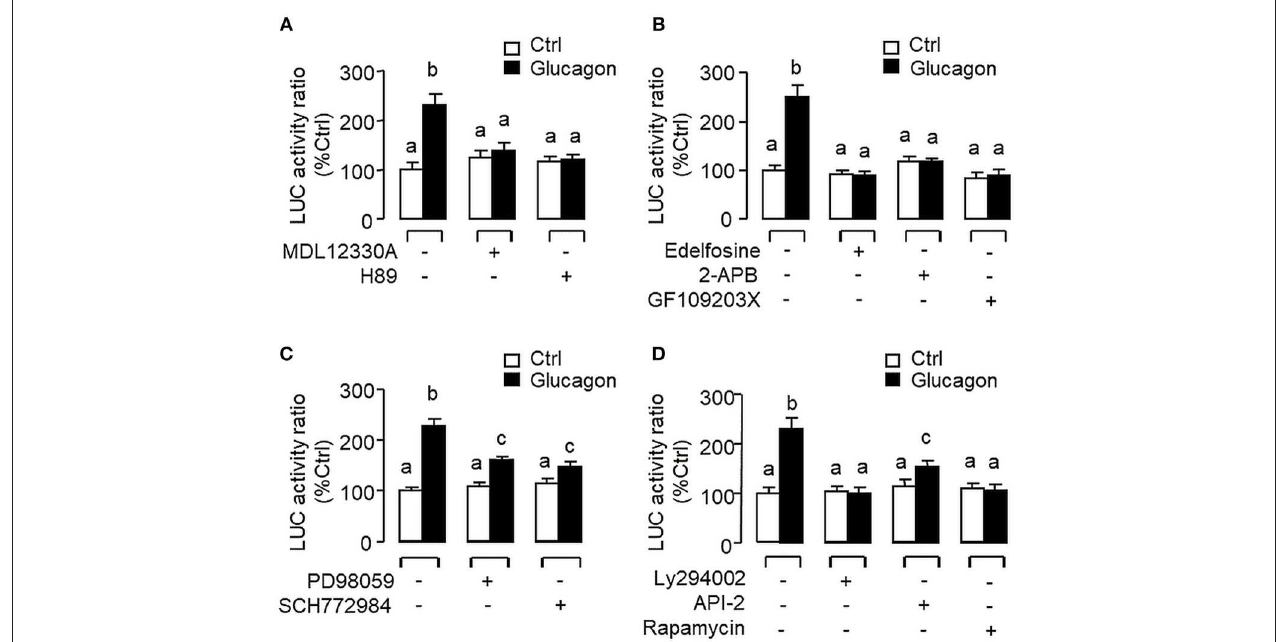
FIGURE 12 | Post-receptor signaling for glucagon-induced IGF-I promoter activity expressed in α T3 cells. After transfection with pIGF1(-1077).Luc, α T3 cells were treated with glucagon (100nM) for 24h in the presence of (A) the AC inhibitor MDL12330A (20 µ M) or PKA blocker H89 (20 µ M), (B) the PLC inhibitor Edelfosine (20 µ M), IP 3 receptor blocker 2-APB (100 µ M) or PKC inactivator GF109203X (10 µ M), (C) the MEK 1 / 2 inhibitor PD98059 (10 µ M) or ERK 1 / 2 inhibitor SCH772984 (10nM), or (D) the PI3K inhibitor Ly294002 (10 µ M), Akt blocker API-2 (2 µ M), or mTOR inactivator Rapamycin (20nM). After drug treatment, cell lysate was prepared and used for luciferase activity